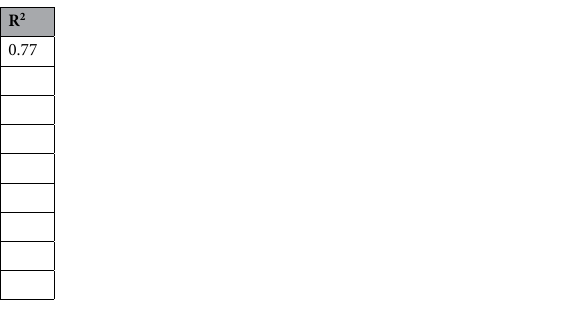
Table 6. Results of research structural